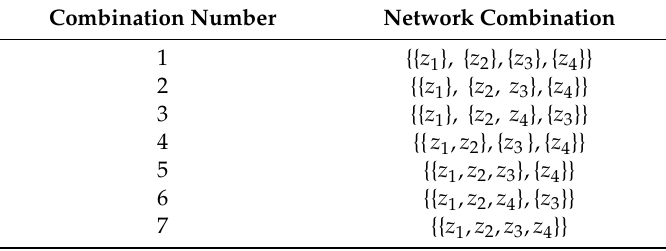
Table 3. Network combinations for the example